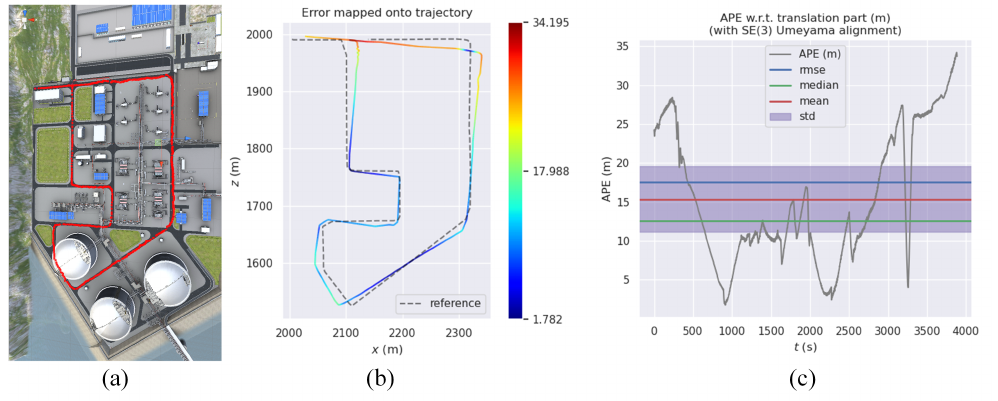
Figure 13. Simulation platform experiment. ( a ) The simulation platform. ( b ) The error mapped onto trajectory. ( c ) RMSE of ATE in meters after translation and scale